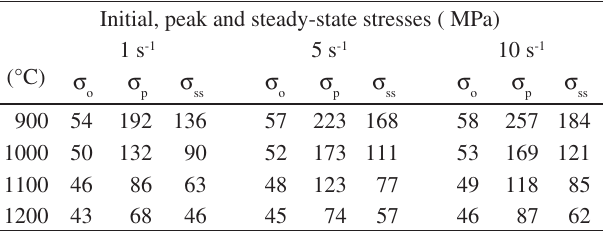
Table 1. Dependence of the initial, peak and steady-state stresses on defor- mation conditions.